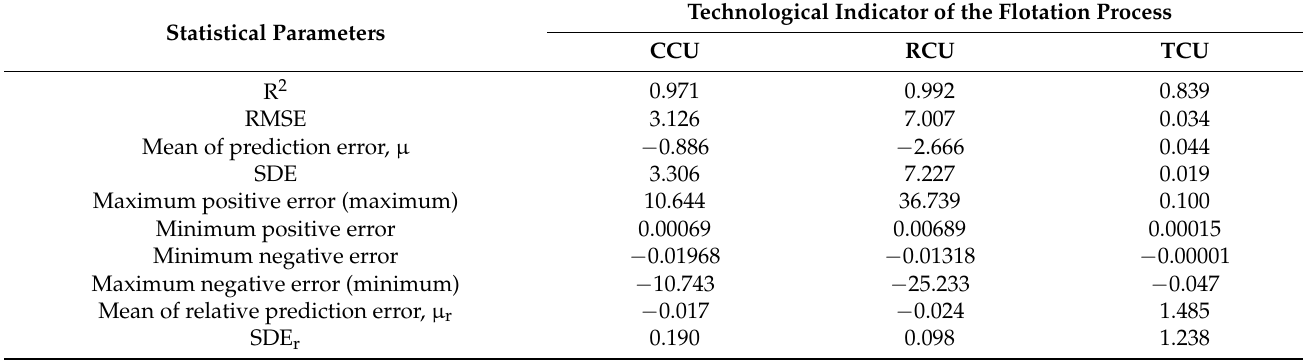
Table 8. Statistical analysis of actual and predicted values using the PMM model. Statistical